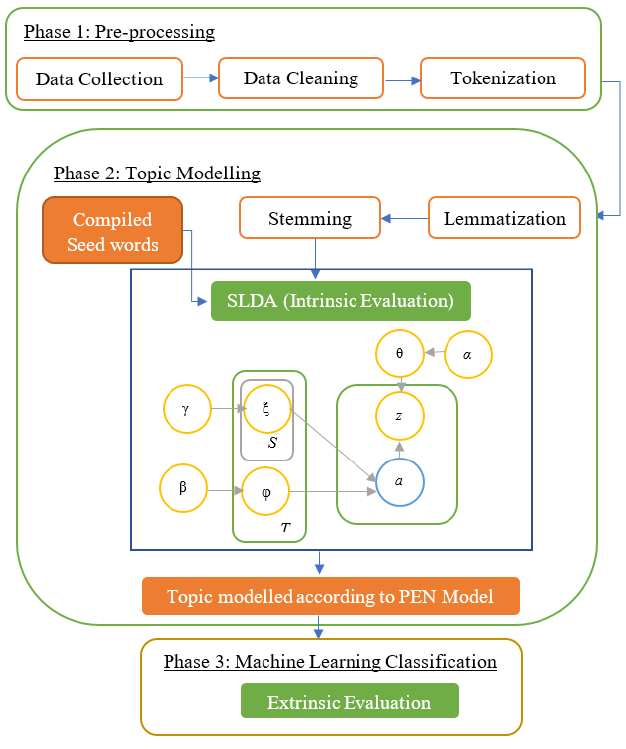
Figure 1. Research Methodology.